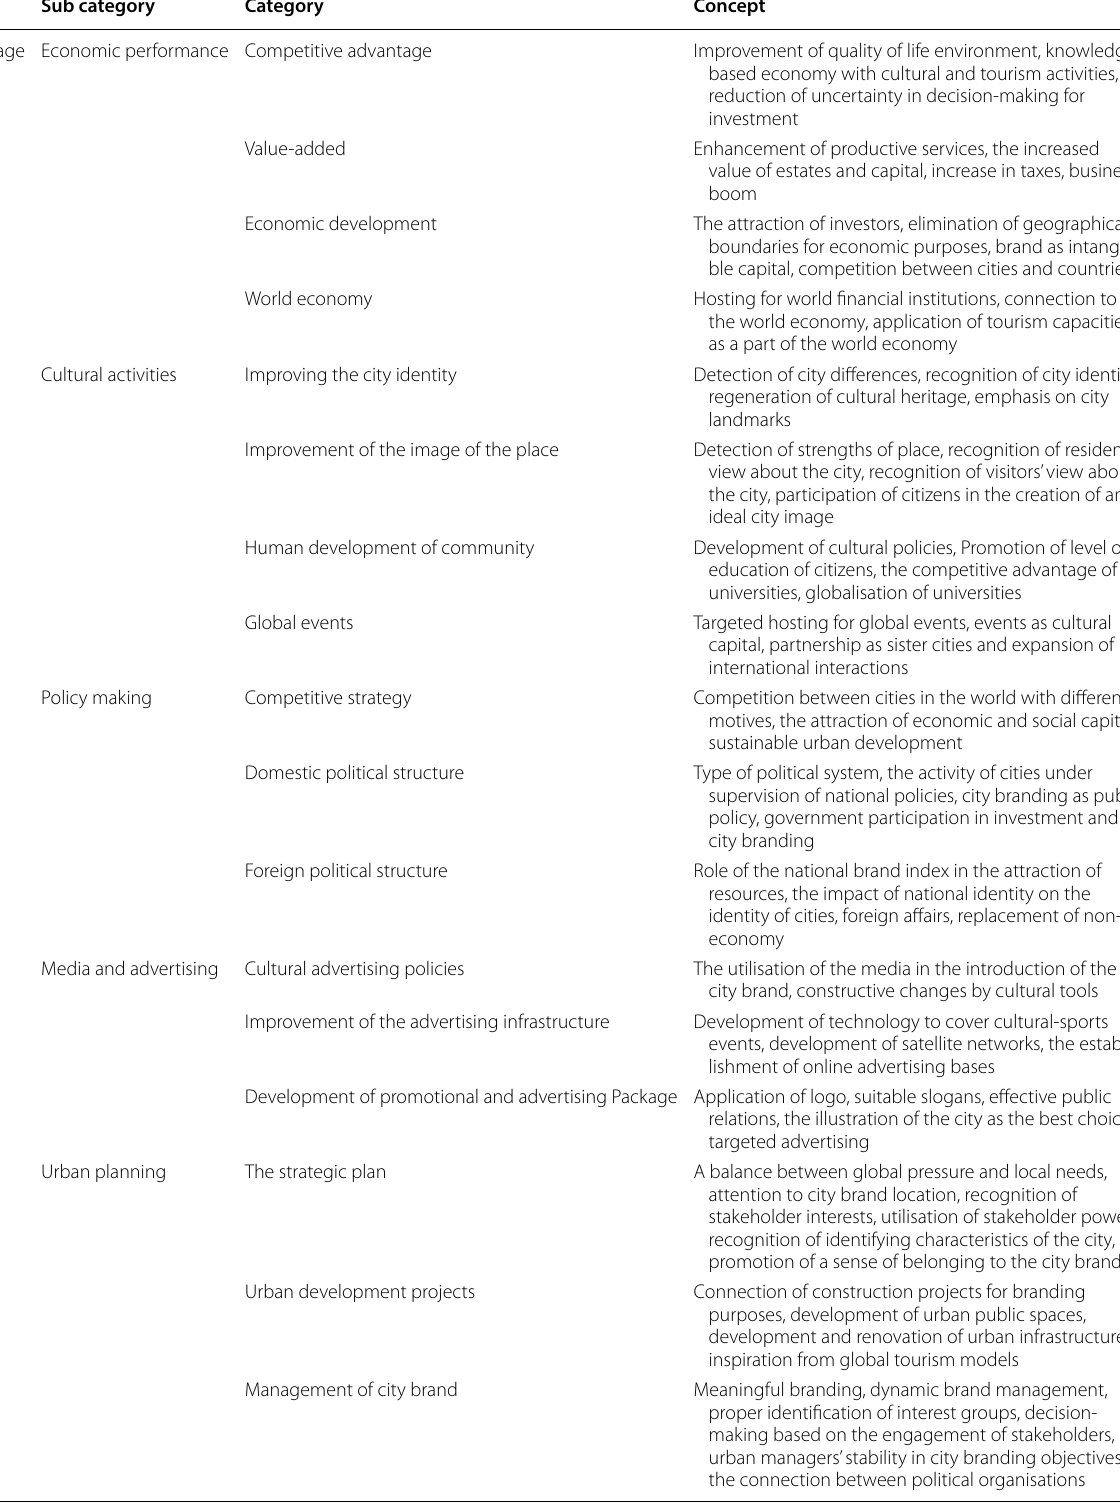
Table 2 Effective factors on city image Sub